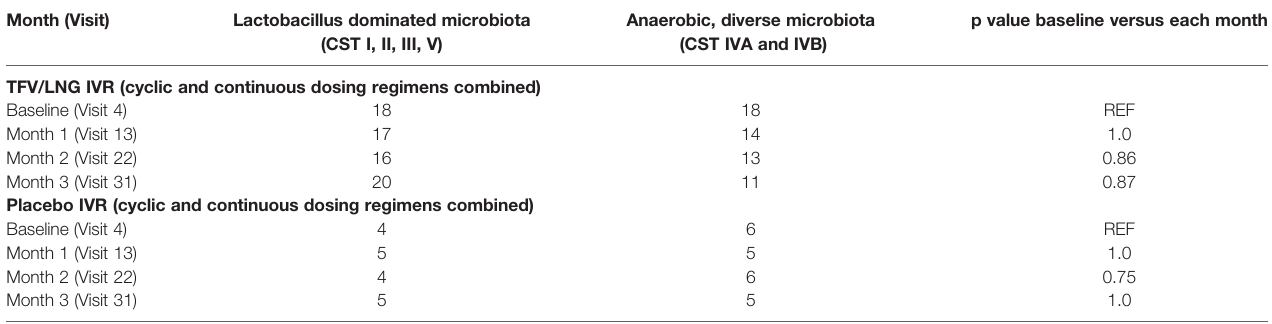
TABLE 1 | Frequency table of community state type (CST) groupings at each visit for placebo and tenofovir/levonorgestrel intravaginal ring users (cyclic and continuous dosing cohorts combined).